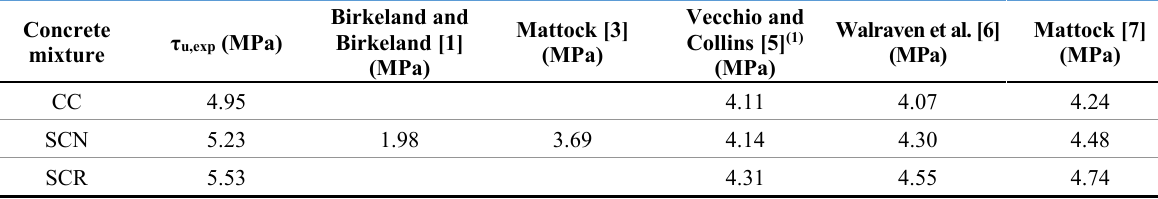
Table 6. Experimental ultimate stress and estimates based on literature equations.